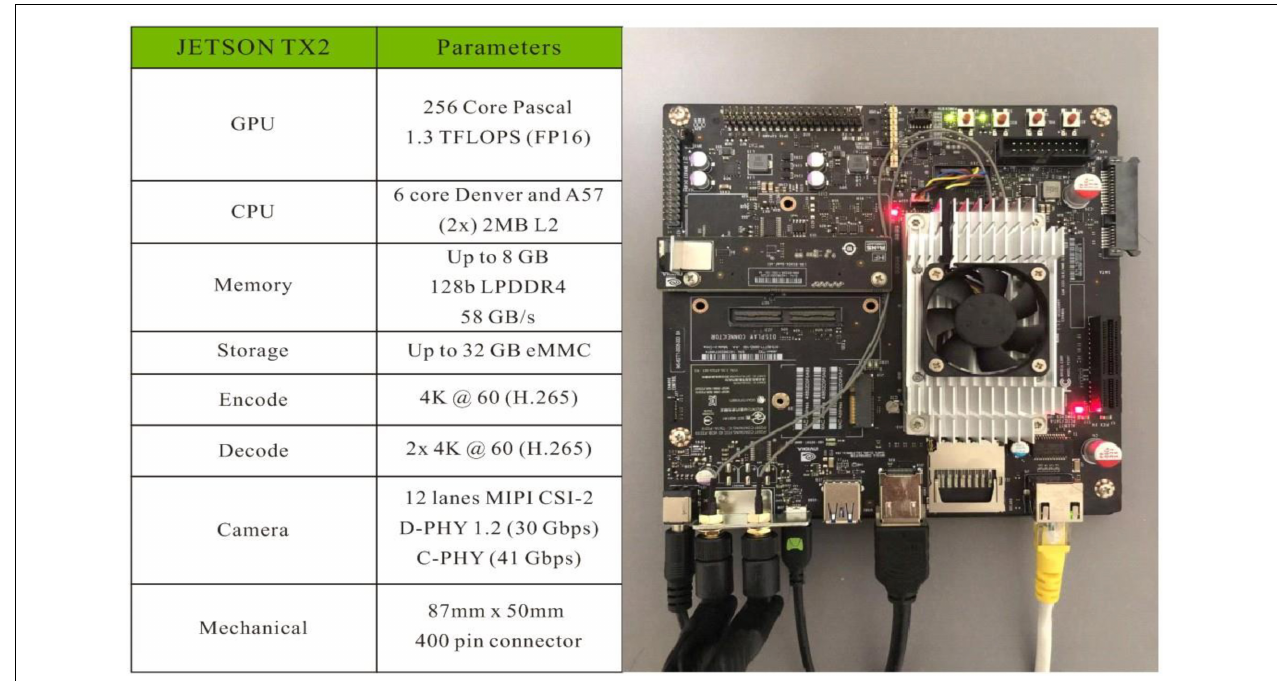
FIGURE 3 | NVIDIA Jetson TX2